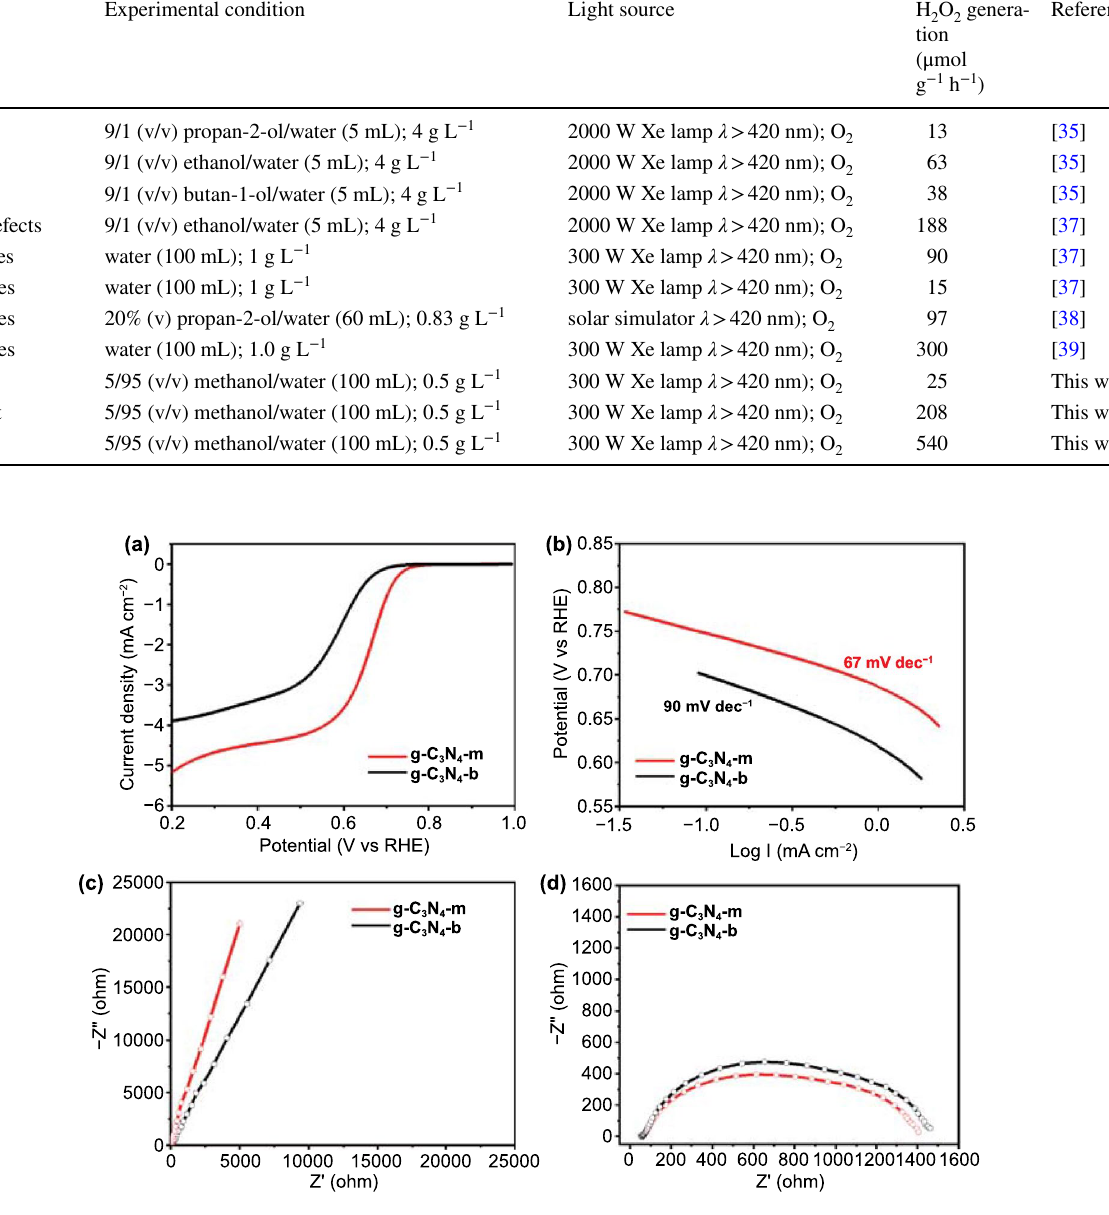
Fig. 7 a Linear sweep voltammograms (LSV) curves of ORR. b Tafel plots, and Nyquist plots measured at c OCV and d 0.6